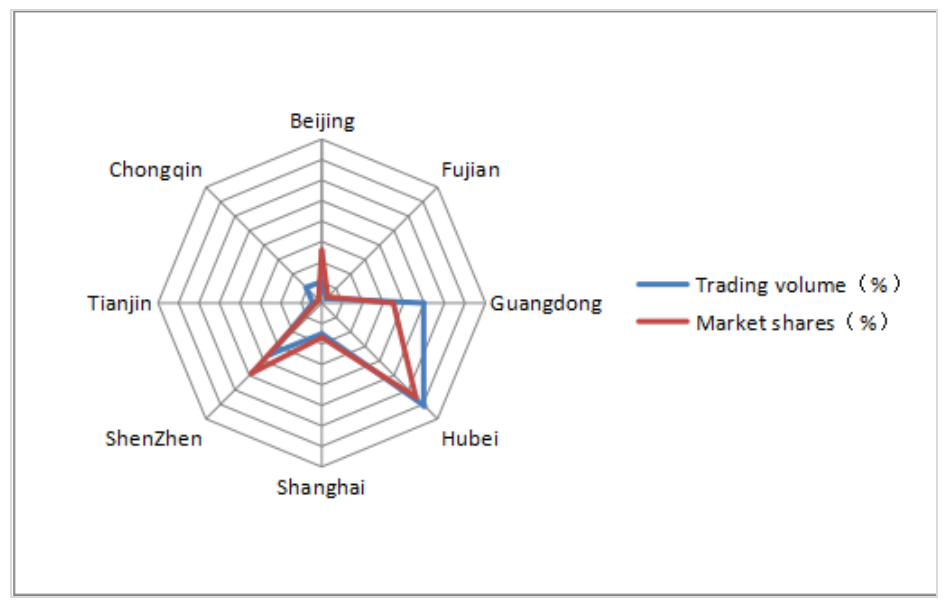
Figure 2. Trading volume in first trading day of each quarter during 2013 to 2017 in Chinese ETS pilots [55].